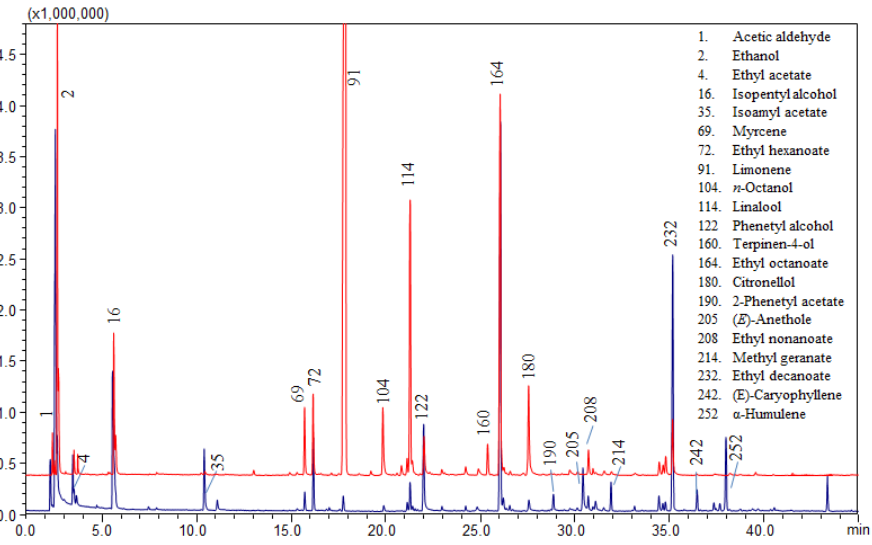
Figure 2. Comparison between volatile profile of the orange flavored beer sample 4 (in blue ) and sample 1 spiked with 1.5% orange peel (in red ).